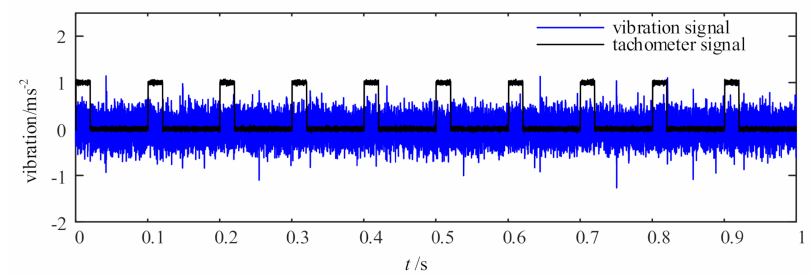
Figure 10. Simulation signal waveform (vibration and